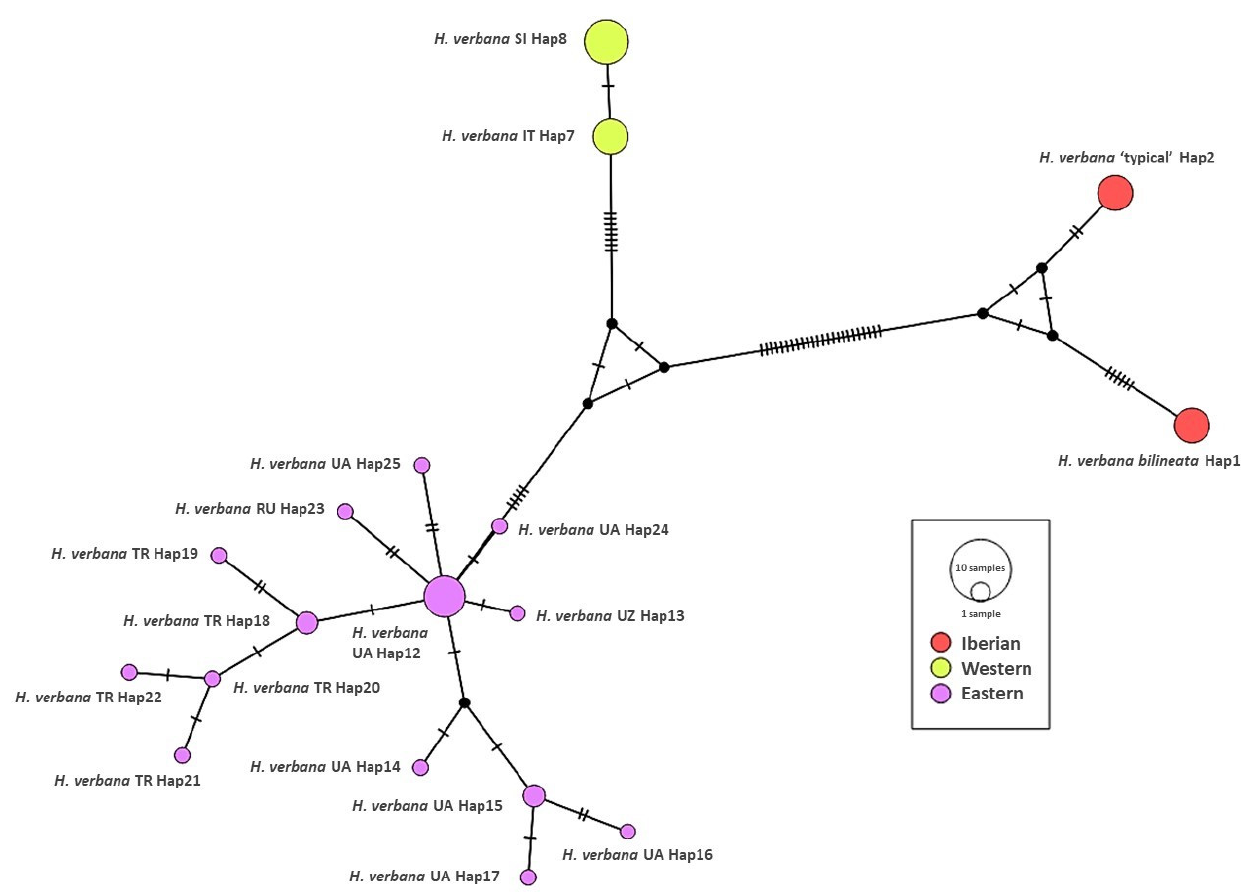
Figure 3. Median joining network of Hirudo verbana. The bars on branch length represent the number of substitutions.